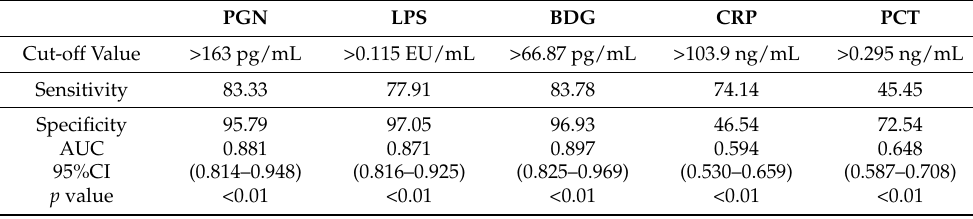
Table 6. Efficacy evaluation of GN, LPS, BDG, CRP, and PCT in the diagnosis of